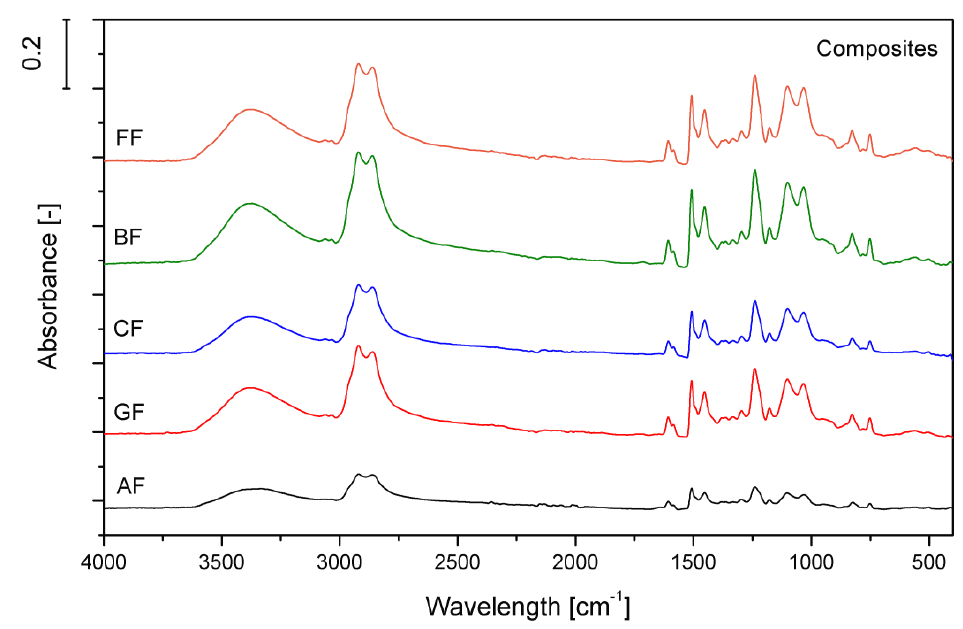
Figure 4. FTIR-ATR spectra of EP laminates.